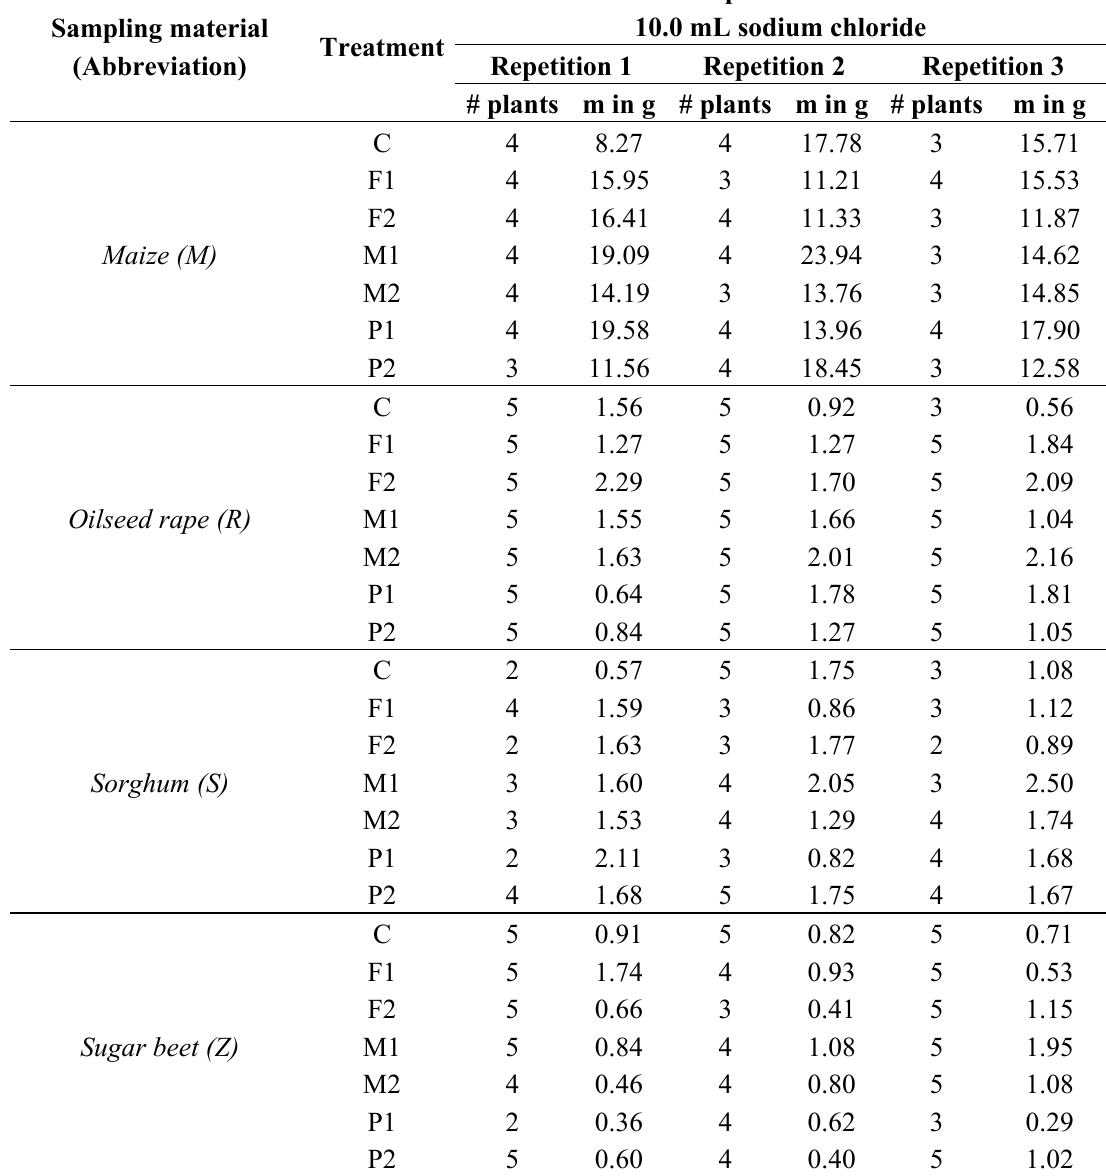
Table S2. Sampling details: treated plants. Treatments: C, control; F, lichen; M, moss; P,